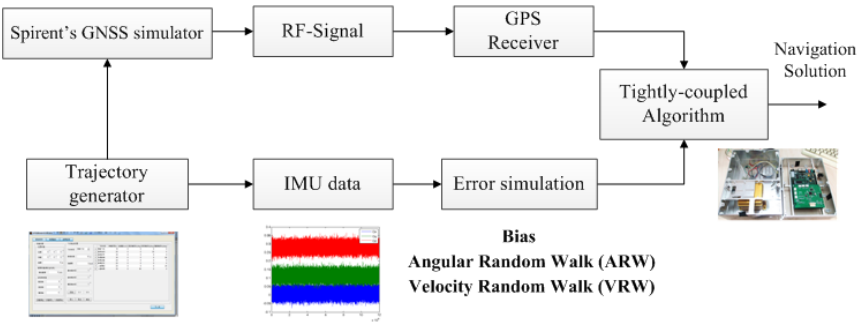
Figure 6. Simulation experiment